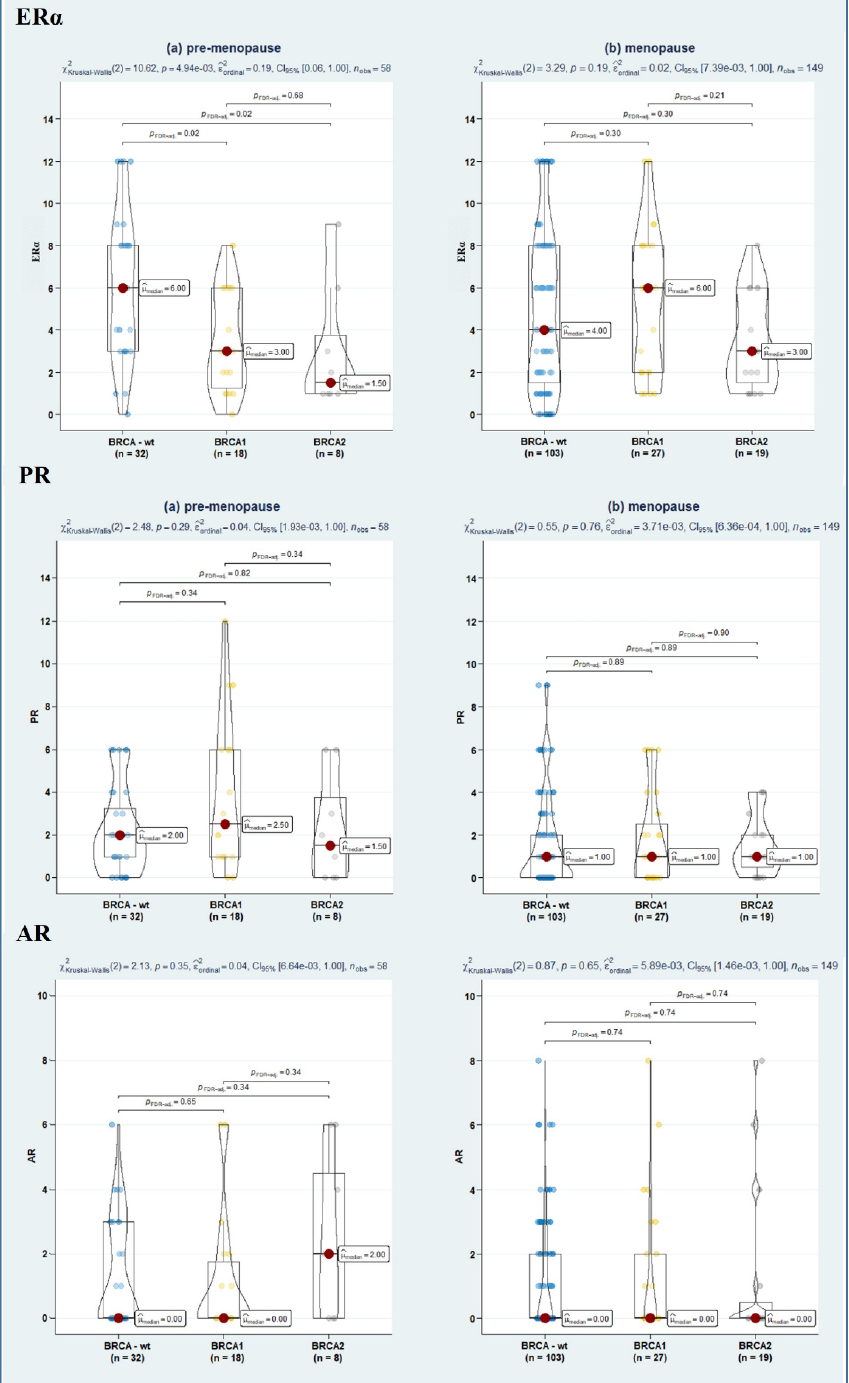
Figure 2. Violin plots depicting the relationship between ER α ( upper panel ), PR ( in the middle ), and AR ( lower panel ) in BRCA-wt, BRCA1, and BRCA2 mutated women according to menopausal status. Both overall and pairwise comparisons are reported, with FdR correction. Blue, yellow and grey dot respectively represents BRCA-wt, BRCA1 and BRCA2 patients pertaining that score of molecular marker.